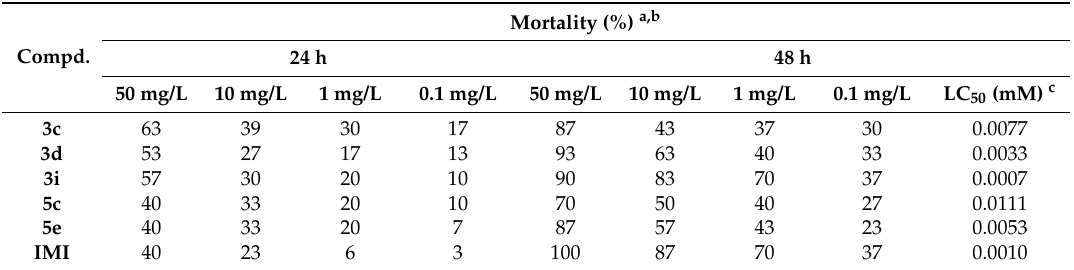
Table 2. Insecticidal activities of compounds 3c , 3d , 3i , 5c , 5e and imidacloprid (IMI) against M. persicae .